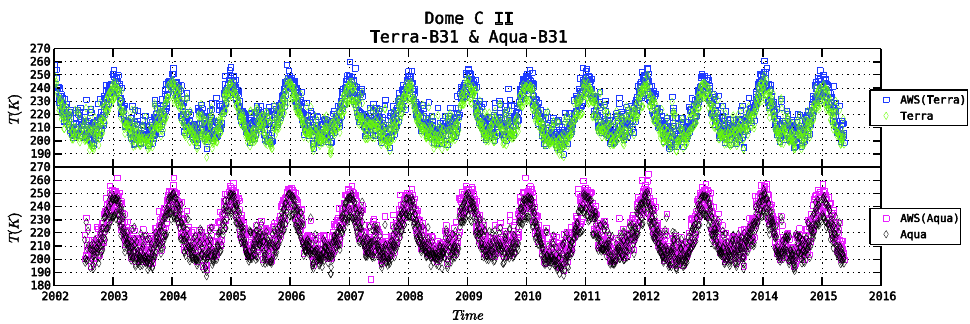
Figure 5. Lifetime temperature observations over Dome C using AWS, T- and A- MODIS band 31.